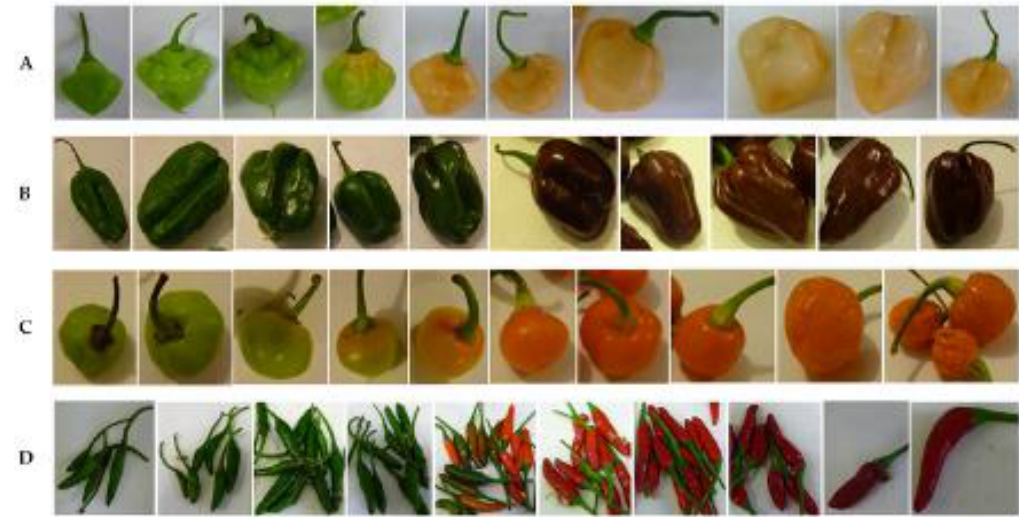
Figure 2. Pepper fruits assayed for their capsiate accumulation patterns during development and maturation. Fruits of ‘Habanero’ ( A ), ‘Habanero Roxo’ ( B ), ‘Bode’ ( C ), and ‘Malagueta ( D ) at 13, 20, 27, 34, 41, 48, 55, 62, 69, and 76 dpa from left-to-right.